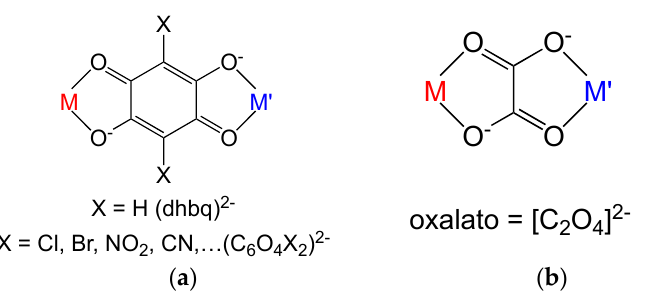
Figure 1. ( a ) The anilato family of ligands (C 6 O 4 X 2 ) 2 − showing the typical bis-bidentate coordination mode also shown by the oxalato ligand ( b ). Table 1. Magnetic properties of all the structurally characterized hetero-metallic layered compounds